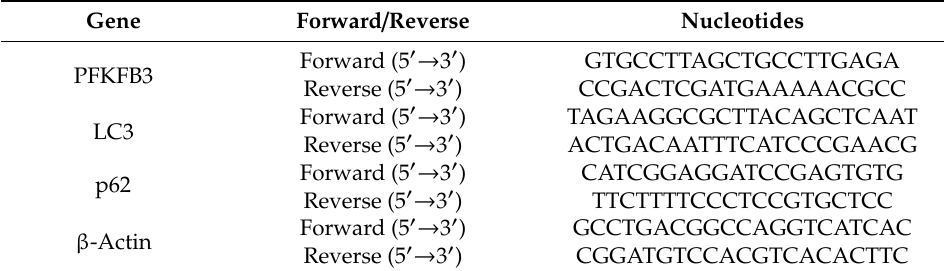
Table 1. Primer sequences for Real-time PCR